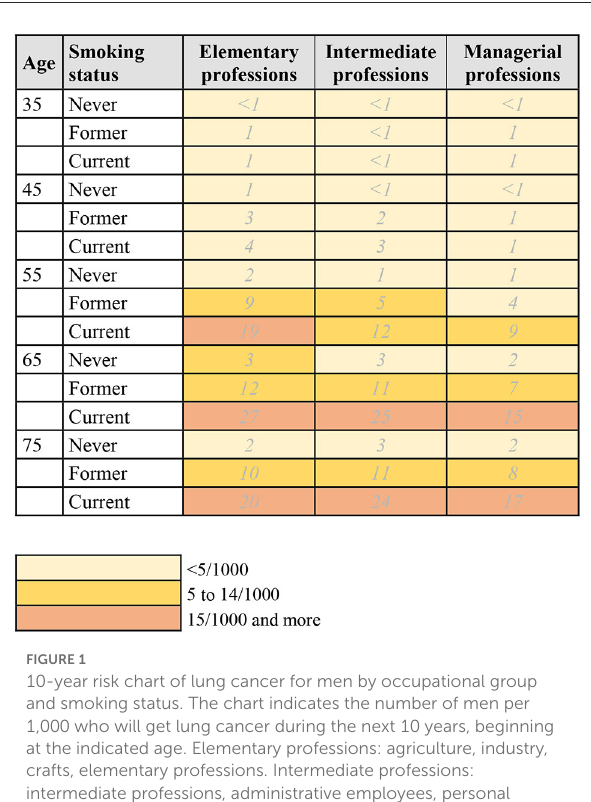
FIGURE1 10-year risk chart of lung cancer for men by occupational group and smoking status. The chart indicates the number of men